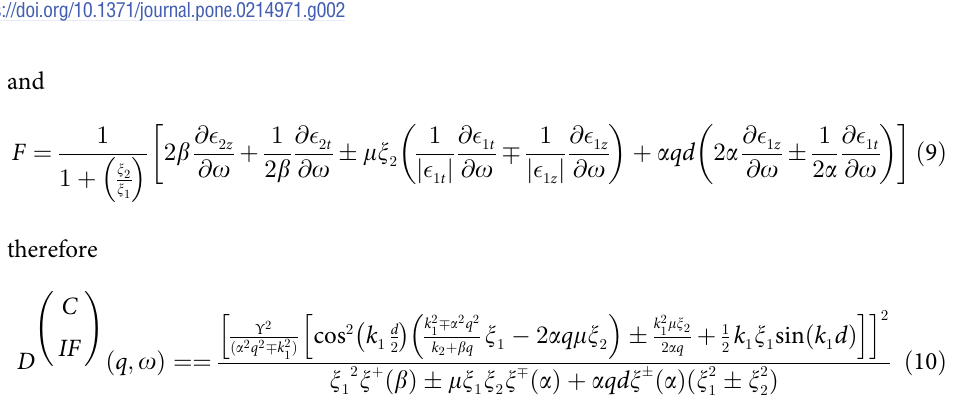
( ω ) and � 2 ( ω ) for GaN are designated in blue and magenta. z t